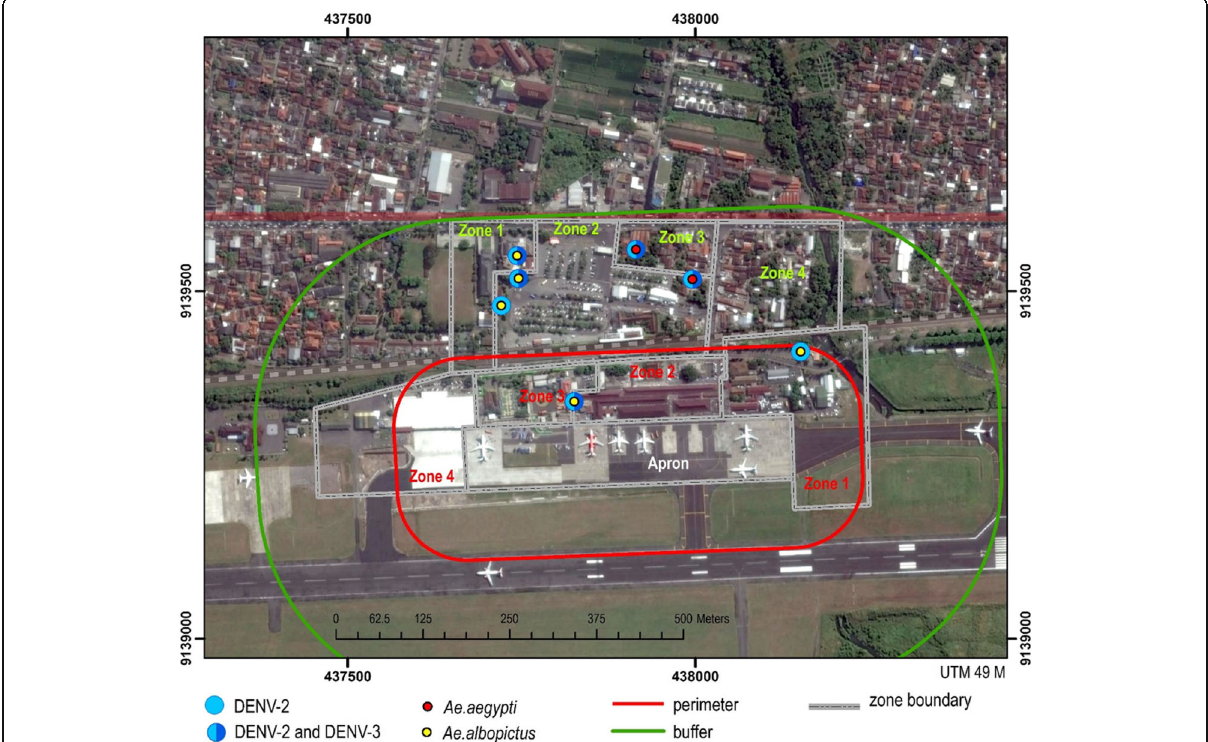
Fig. 2 Distribution map of dengue virus and dengue cases in Adisucipto Airport Yogyakarta. Four zones in perimeter area are cargo log (zone 1), terminal A (zone 2), office (Zone 3), and terminal B (zone 4), while four areas in buffer area are terminal B (zone 1), parking and public facilities (zone 2), neighborhood 7 (zone 3), and neighborhood 8 (zone 4). One spot was positive in perimeter area for DENV-2 and one spot positive for DENV-2 and DENV-3, both of which were also positive for Ae . albopictus . One spot was positive in buffer area for DENV-2 and two spots were positive for DENV-2 and DENV-3, all of which were also positive for Ae . albopictus . There were two spots positive in buffer area for DENV-2, DENV-3, and Ae .